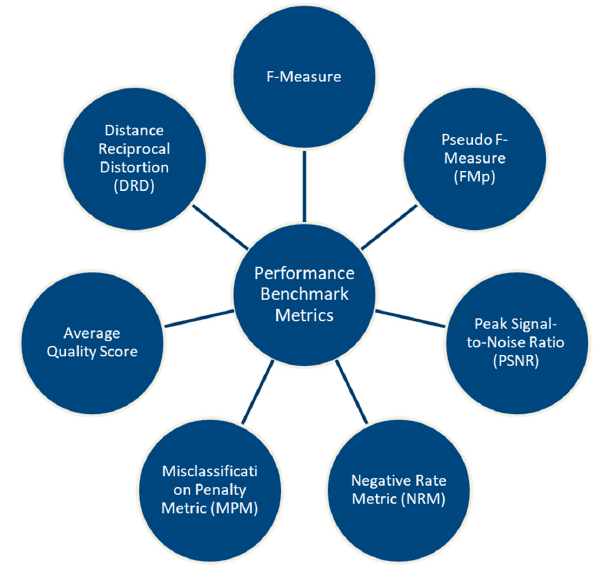
Figure 16. Benchmark performance metrics for document binarization methods.